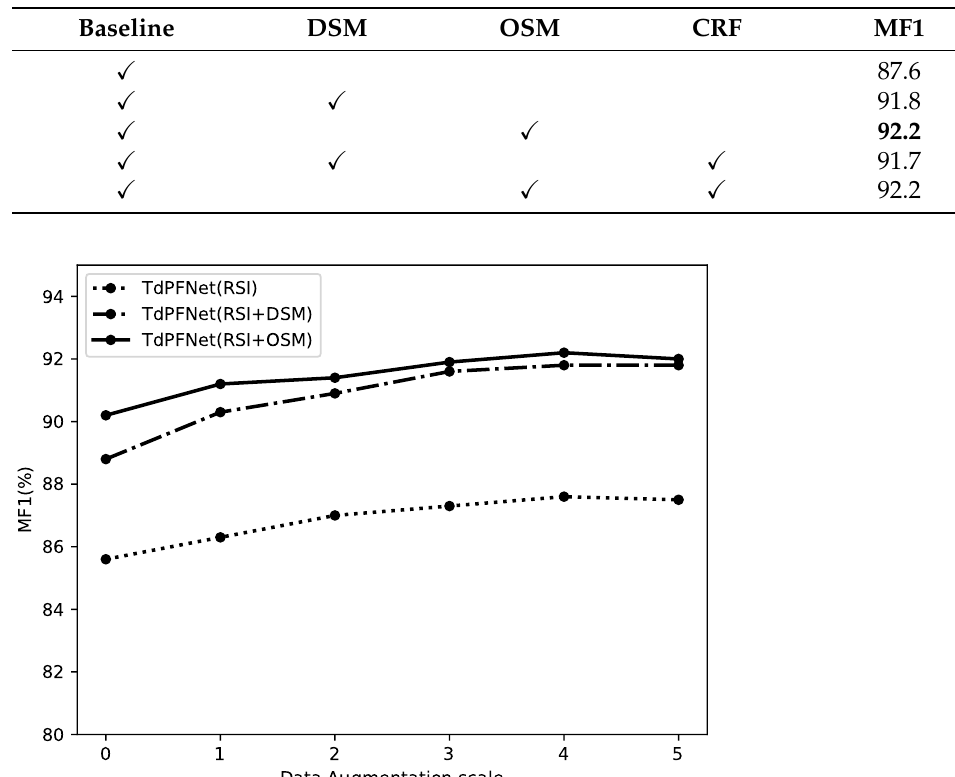
Figure 10. The ablation study on different data augmentation scales on Potsdam test